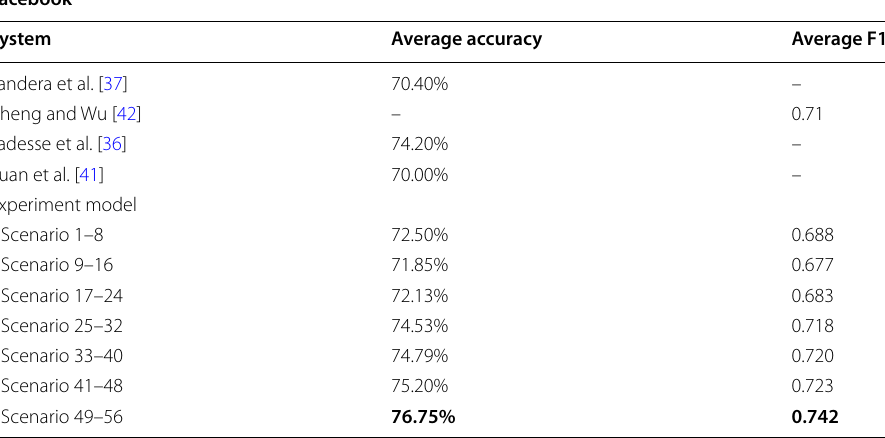
Table 10 Comparison Model Performance (Facebook Dataset)